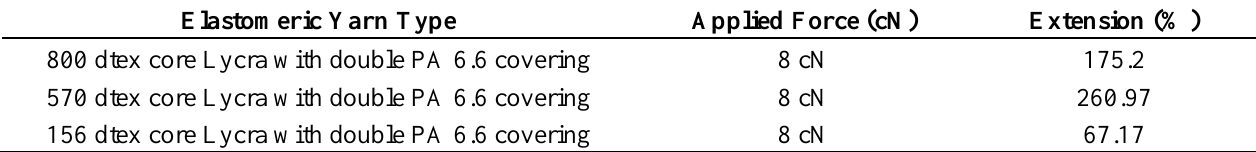
Table 2. Elastomeric yarn elongation values at 8 cN applied tension.